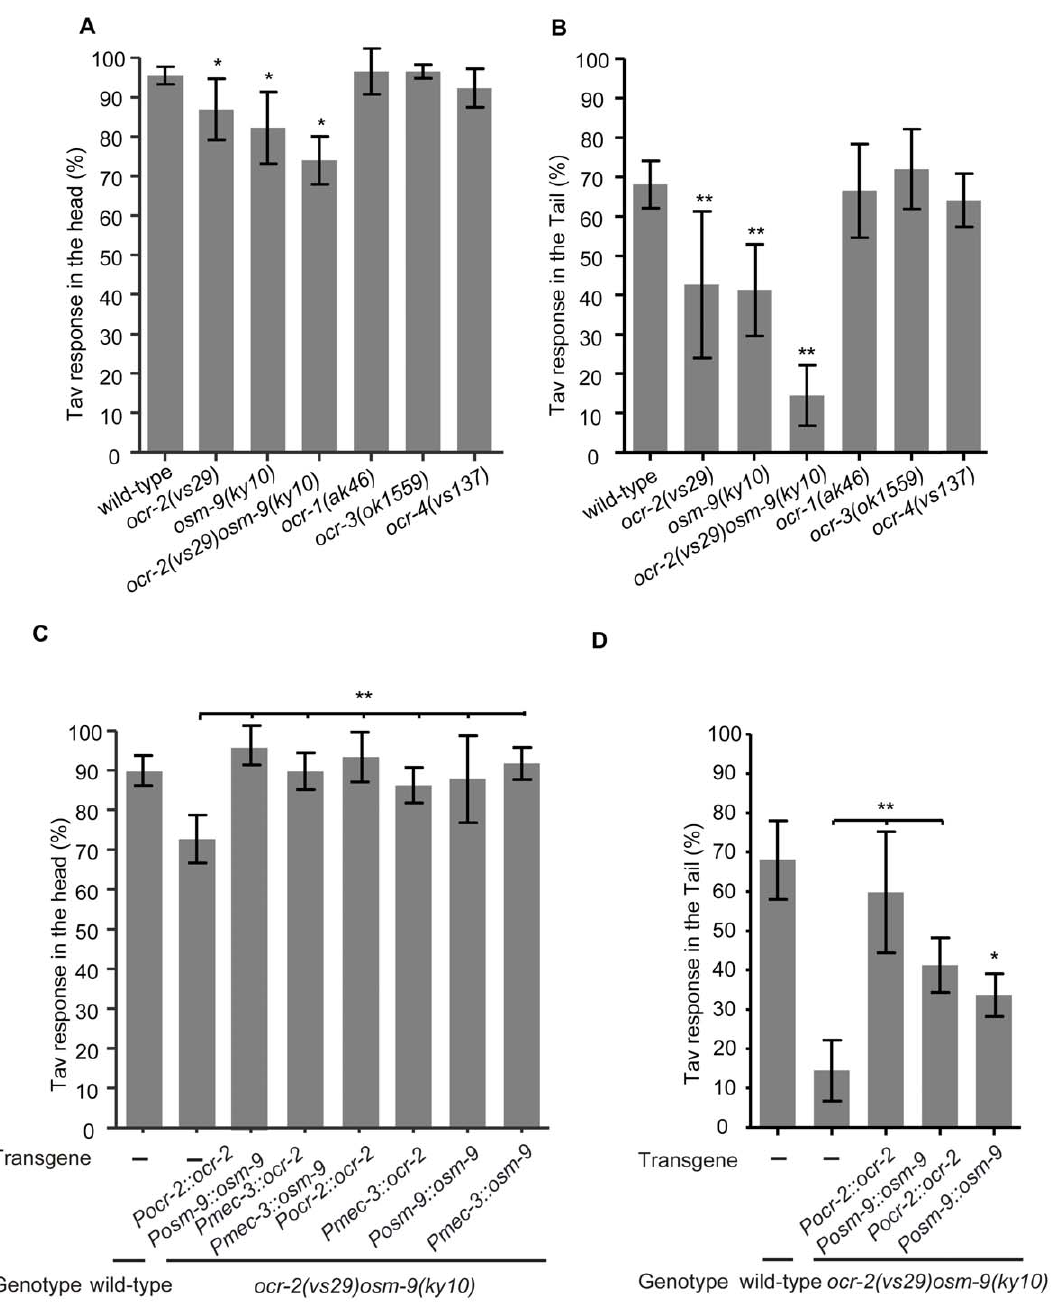
Figure 4. OCR-2 and OSM-9 contribute to the Tav response in the FLP neurons in the head and in the PHC neurons in the tail of C.elegans . (A), (B) The head and tail Tav of osm-9 and ocr single and double mutants are shown. (C) The defective Tav response in the head of the ocr-2 osm-9 double mutant was rescued by the expression of ocr-2 and/or osm-9 full length genomic DNA as well as by expression of their respective cDNAs under the control of the mec-3 promoter. (D) The expression of either ocr-2 or osm-9 full-length genomic DNA was sufficient for at least partial rescue of the defective Tav response in the tail of the ocr-2 osm-9 double mutant. (*P , 0.01; **P , 0.001, n . 80). Error bars indicate SD.